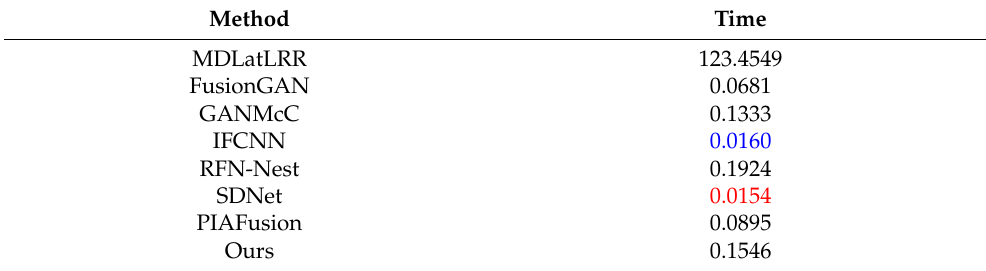
Table 9. The average processing time for each image pair on the 361 MSRS dataset. The red value indicates the best result and the blue value indicates the second best result (unit: